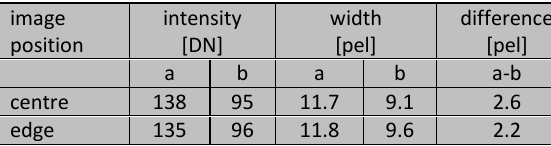
Table 4. Checking of RCD30 images for PRNU and